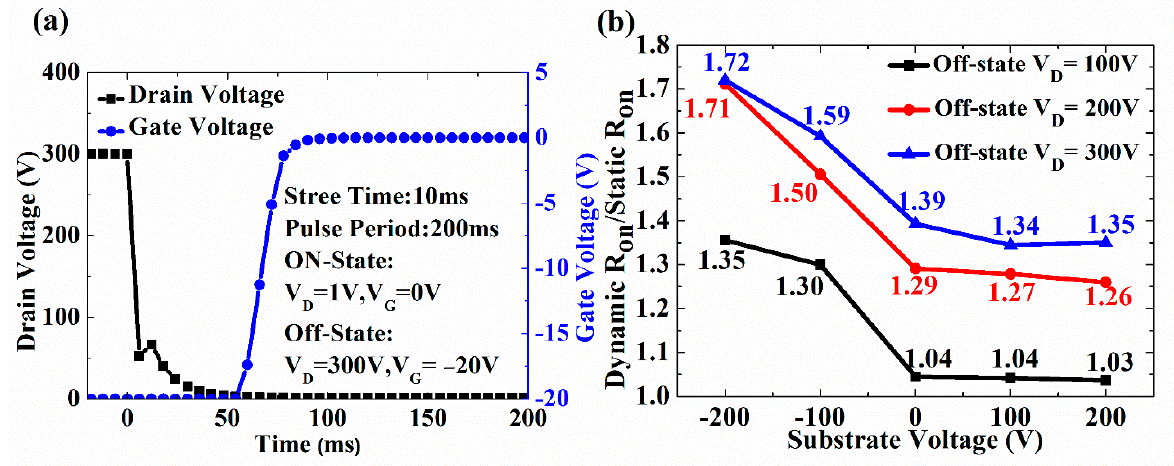
Figure 6. ( a ) Dynamic R on transients of Drain/Gate voltage (V G ) vs. time ( μ s) ( b ) Dynamic R on /static R on ratio at different off-state V D as a function of various V SUB .